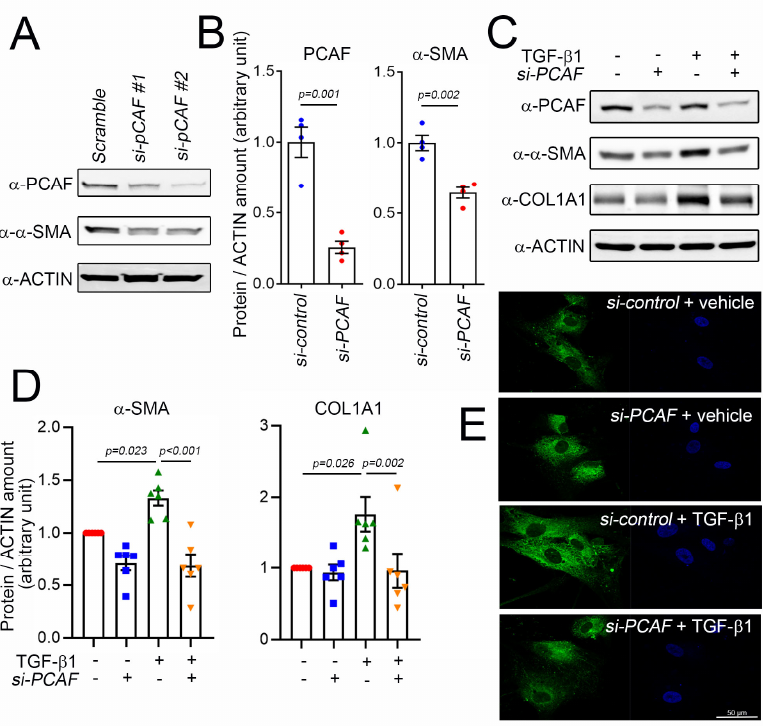
Figure 3. Knockdown of PCAF prevented TGF- β 1-induced COL1A1 and α -SMA in human cardiac fibroblasts. ( A ) Efficiency of two independent sets of PCAF siRNA . For the following studies, PCAF siRNA #2 with better knockdown efficiency was used. ( B ) Treatment with PCAF siRNA #2 reduced the protein amounts of α -SMA and PCAF. ( C ) PCAF siRNA prevented the TGF- β 1-induced increase in α -SMA and COL1A1. ( D ) Quantification results. ( E ) Immunofluorescent analysis to show COL1A1 in human cardiac fibroblasts. Note that the increase in the cytoplasmic abundance of the fluorescence (distribution of COL1A1, third panel) was significantly diminished by the simultaneous treatment with PCAF siRNA (fourth panel).